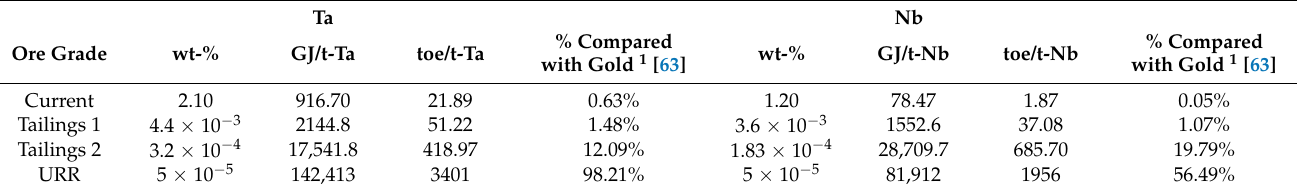
Table 7. Comparisonofthespecificenergyand%oftheenergycomparedwiththegoldbeneficiationprocess.